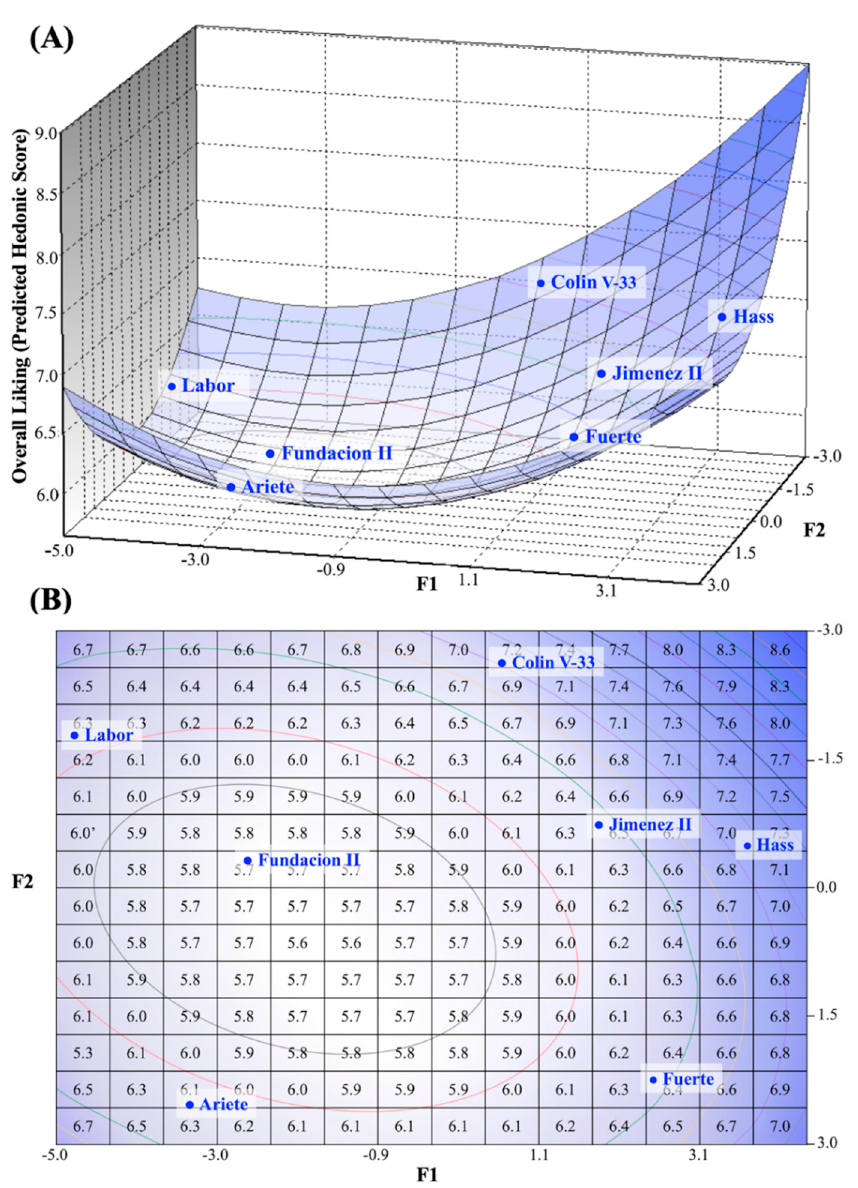
Figure 3. Tridimensional ( A ) and bidimensional ( B ) external preference map obtained by quadratic modeling of the overall liking of frequent avocado consumers ( n = 116) for seven avocado cultivars, and placement of the affective data within sensory descriptive space. Principal component biplot of sensory descriptive data (components F1 and F2) used in construction of external preference map is shown in Figure 2. * Scores in the bidimensional map (B), represent the predictive hedonic